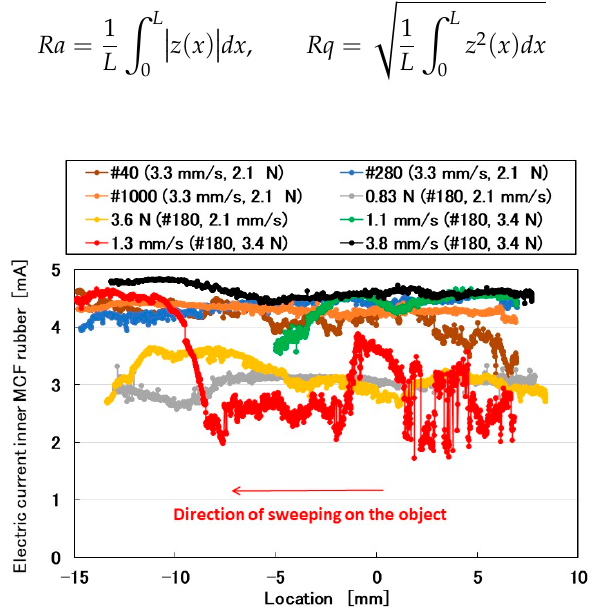
Figure 3. Electrical properties of MCF rubber sensor rubbing over sandpaper in the SFE: the force is presented as the initial normal force just before sweeping. The sweeping velocity is also presented.